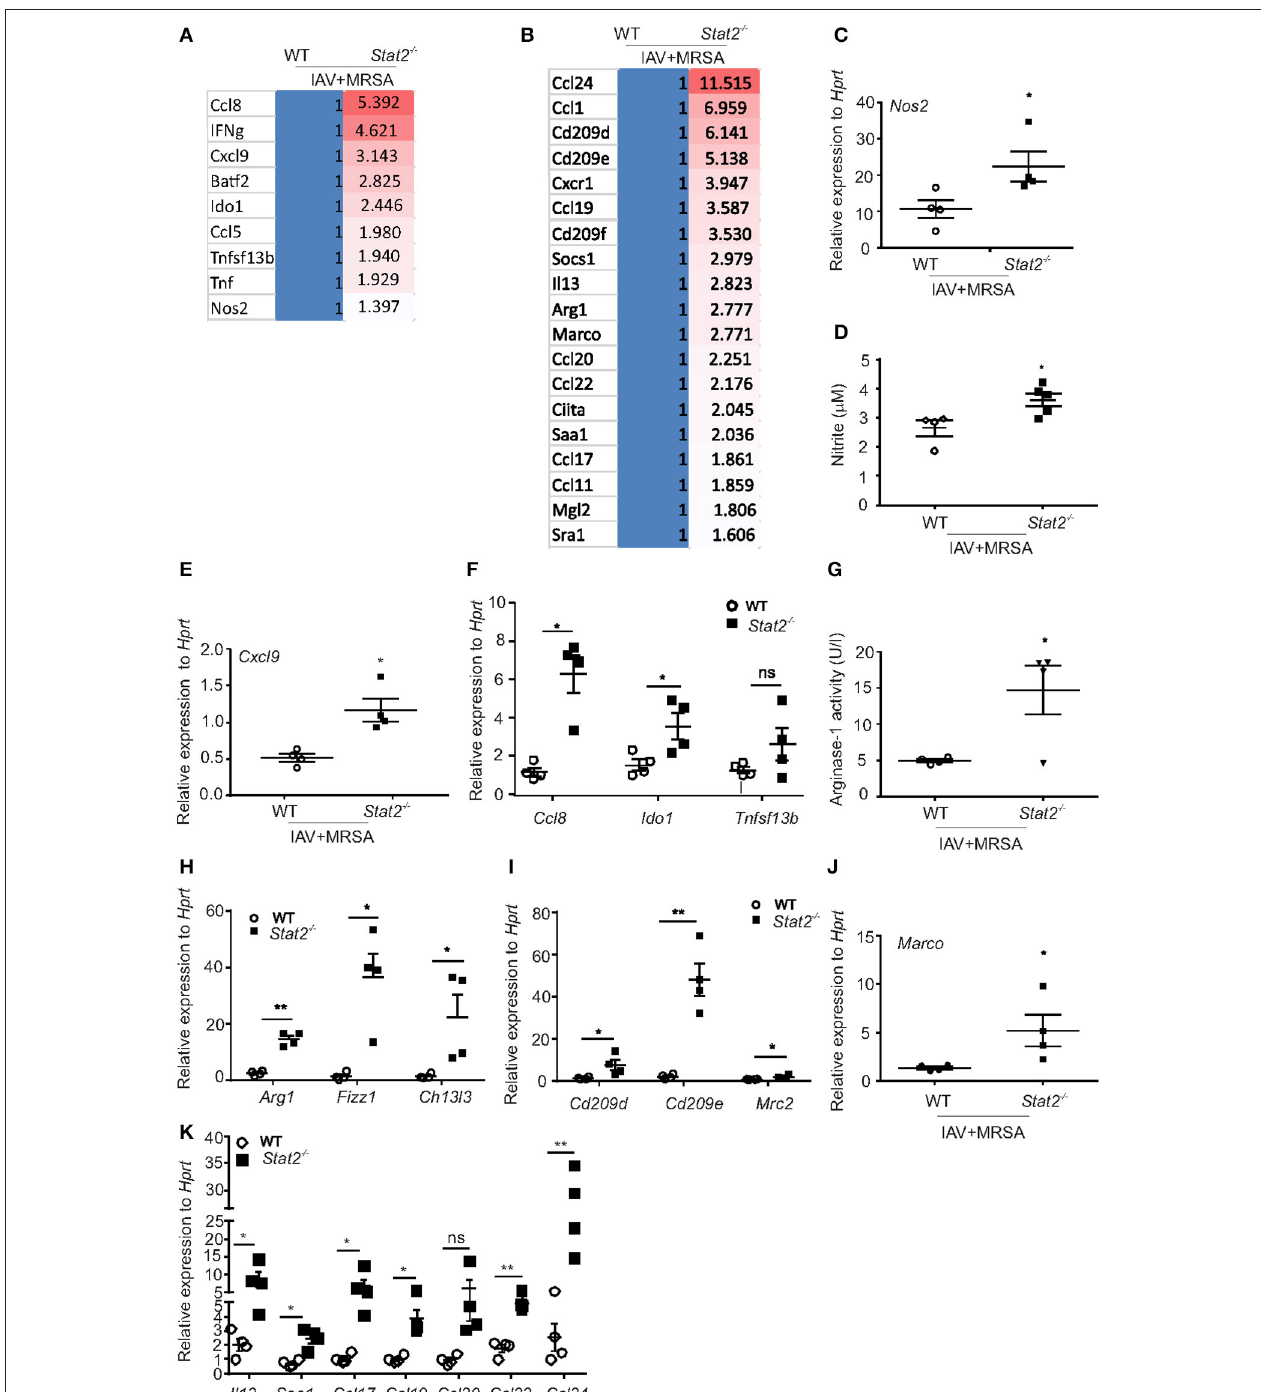
FIGURE 3 | M1 and M2 macrophages are associated with increased bacterial clearance in Stat2 − / − during influenza-MRSA super-infection. WT or Stat2 − / − mice were infected with 100 PFU of influenza for 6 days then challenged with 5 × 10 7 cfu of MRSA for one additional day. Gene expression analyses were measured in lung by RNAseq analysis. Heat-map representing RNA abundance associated with M1 (A) and M2 (B) macrophages from WT and Stat2 − / − mice, N = 4 per group. (C) Nos2 , (D) Nitrite, (E) Cxcl9 , (F) Ccl8, Ido1, Tnfsf13b were analyzed by RT-PCR, N = 4 per group. (G) Arginase-1 activity was determined from BAL samples from both WT and Stat2 − / − mice infected with influenza and MRSA super-infection, N = 4 per group. (H) Arg1, Fizz1 , and Chi3l3 , (I) Cd209d , Cd209e and Mrc2 (J) Marco mRNA expression levels were determined by RT-PCR, N = 3–4 per group. (K) Il13 and Saa1, Ccl17, Ccl19, Ccl20, Ccl22 , and Ccl24 mRNA expression levels were determined by RT-PCR, N = 4 per group. Representative data shown from three or more experiments. Data are represented as mean ± SEM. Data analyzed using 2-tailed Student’s t -test, * p < 0.05, ** p < 0.01, ns, not significant.